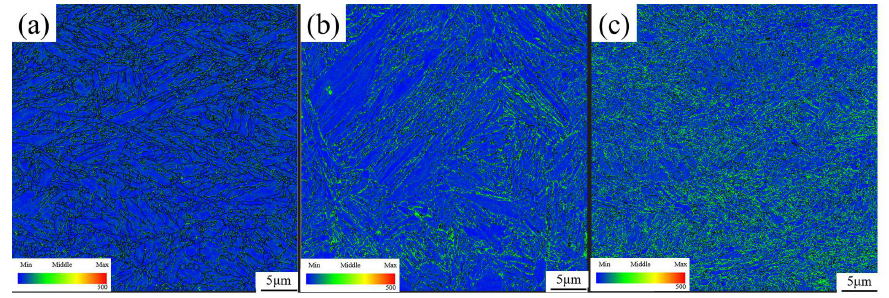
Figure 11. LAM diagrams of ( a ) QP-300, ( b ) IA-680 and ( c ) QA-680 processes.